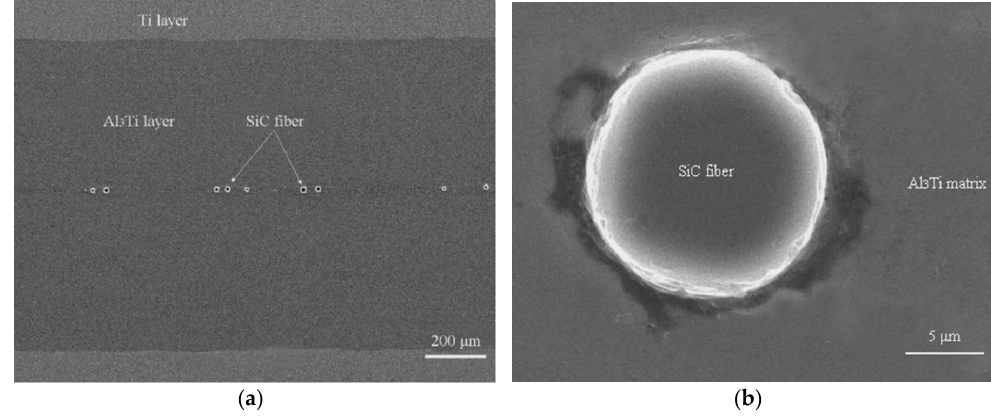
Figure 18. SEM image for the laminated structure of Ti-(SiCf/Al3Ti) composite: ( a ) lower magnification and ( b ) higher magnification.